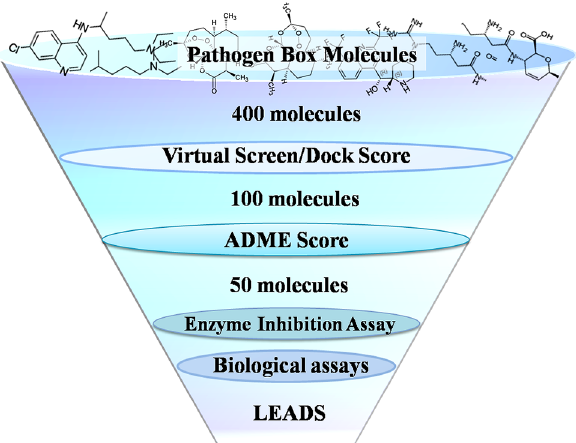
Figure 1. Schematic representation of the methodology for identification of potent hits against PfUCHL3: a flowchart illustrating the series of in-silico and in-vitro protocols employed to identify potent